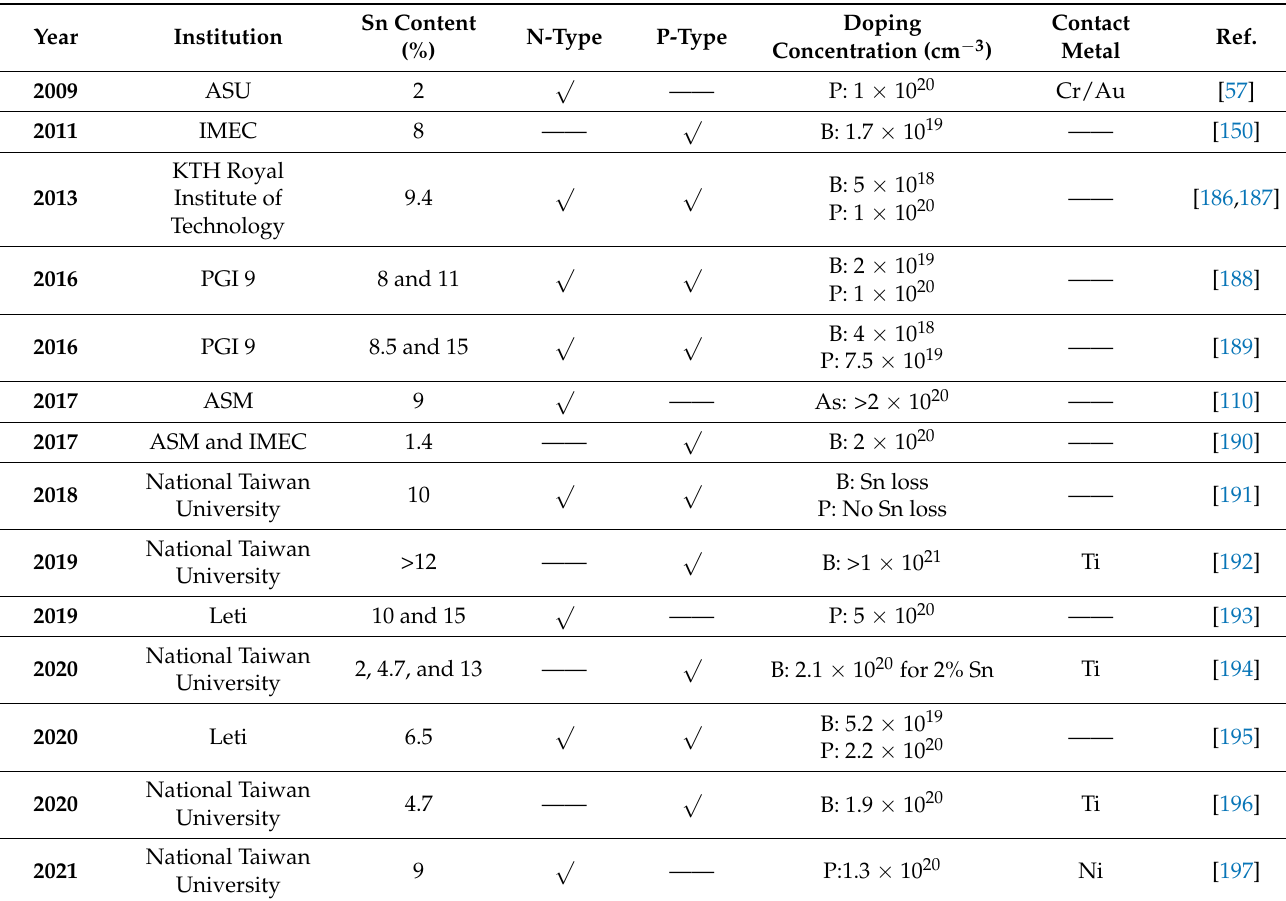
there is a competition between Sn and B atoms [150,185]; (II) excess partial pressure for PH 3 contributes to poor material quality due to P segregation; (III) B 2 H 6 partial pressure concentration; (IV) more P could be incorporated into Ge and GeSn by using high order precursors; (V) boron δ -doping layers are helpful for highly doped GeSn growth, and the maximum B concentration can reach up to 1 × 10 20 cm − 3 ; and (VI) the doping efficiency of As-doped GeSn is better than that of P-doped GeSn [110]. Table 2. Summary of reported B-doped GeSn, P-doped GeSn, and As-doped GeSn in terms of year, institution, Sn content, doping type, doping concentration, and contact